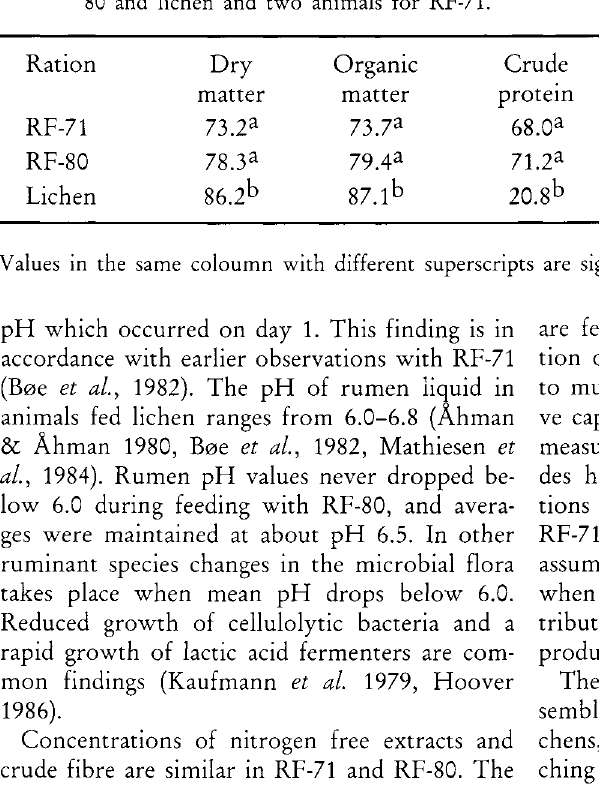
Table 5. Nutritive value of feeds determined in diges tibility trials. Energy values given are